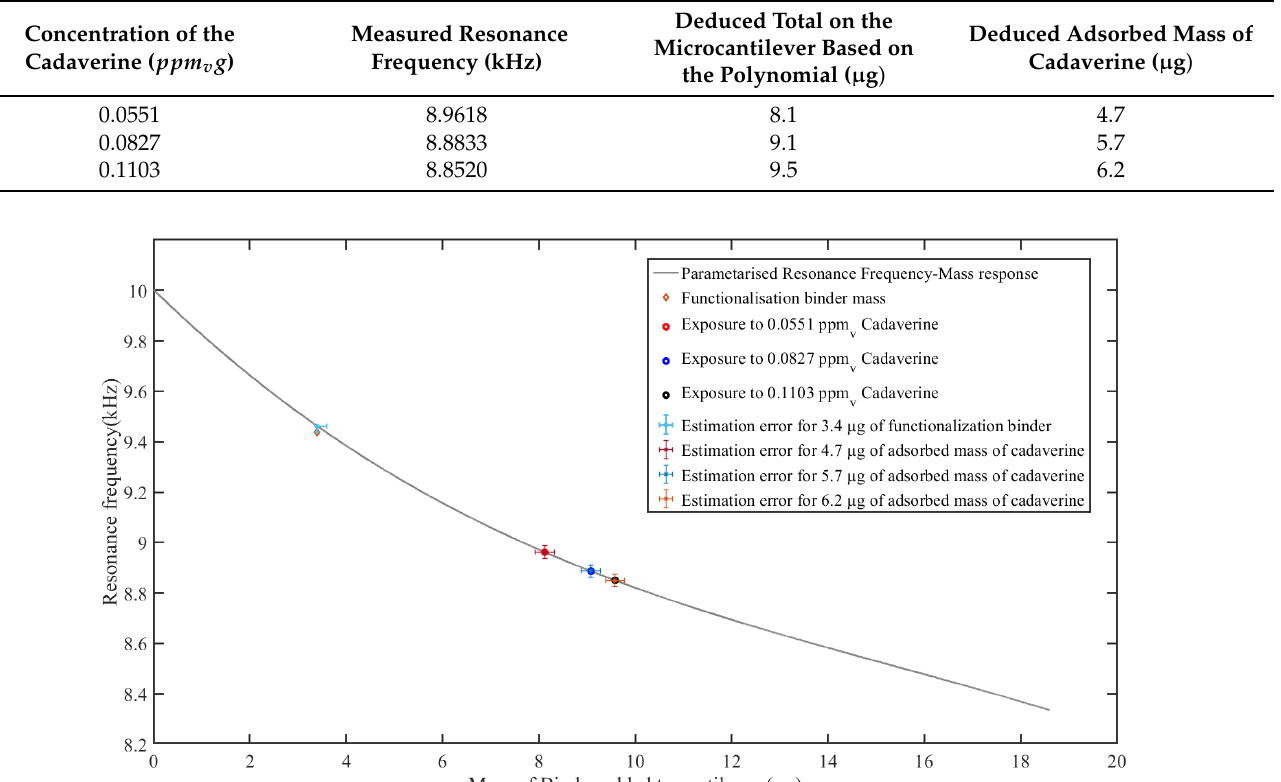
Table 5. Estimation of the mass of cadaverine adsorbed when the functionalized microcantilever with 3.4 µ g of the binder is exposed to different concentrations of cadaverine.